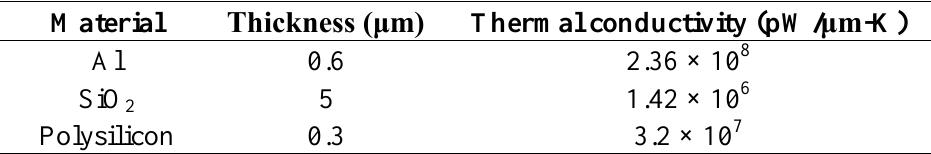
Table 1. Thickness and thermal conductivity of the